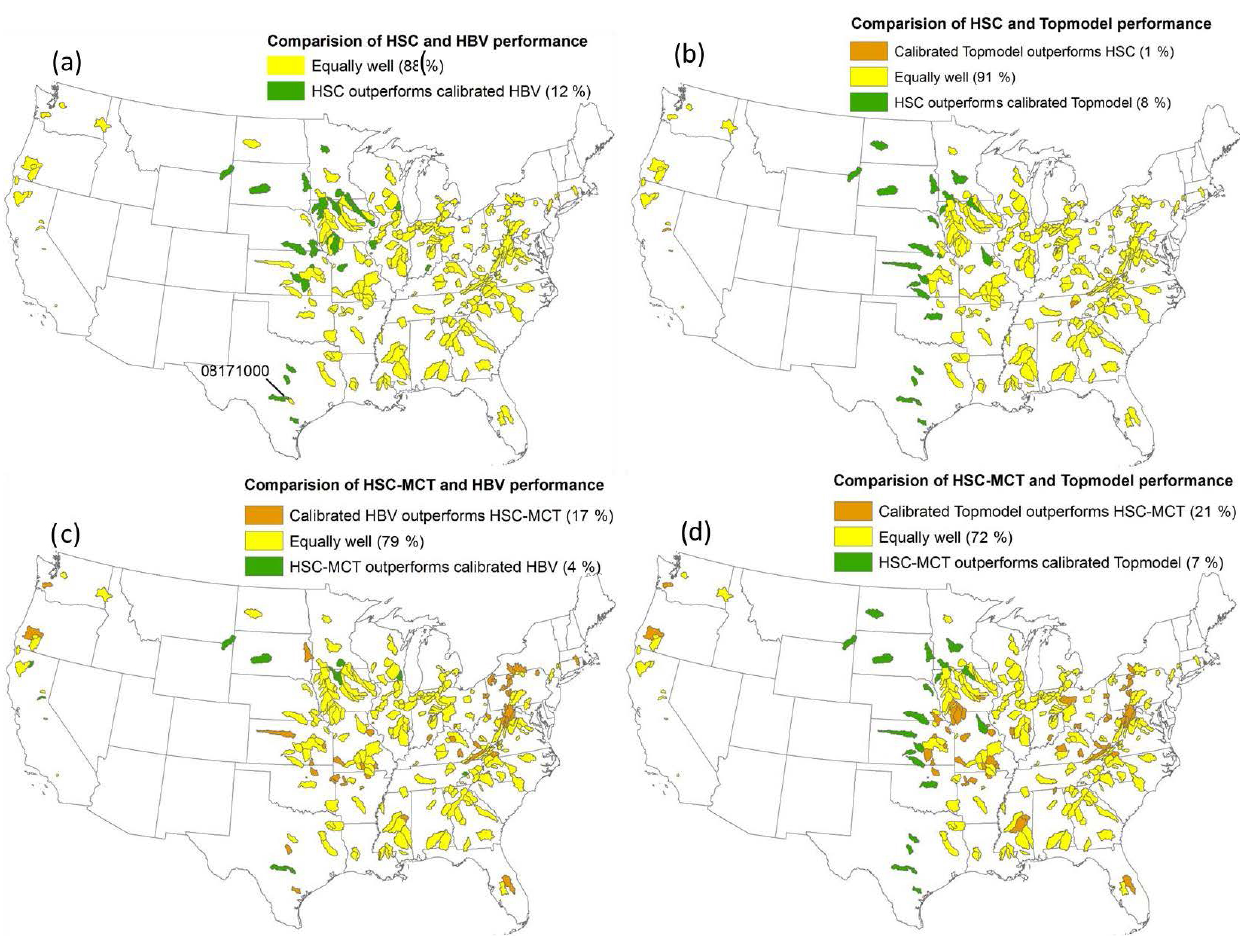
Figure 14. Performance comparison of the HSC and HSC-MCT models compared to two benchmark models, HBV and TOPMODEL, for the 323 MOPEX